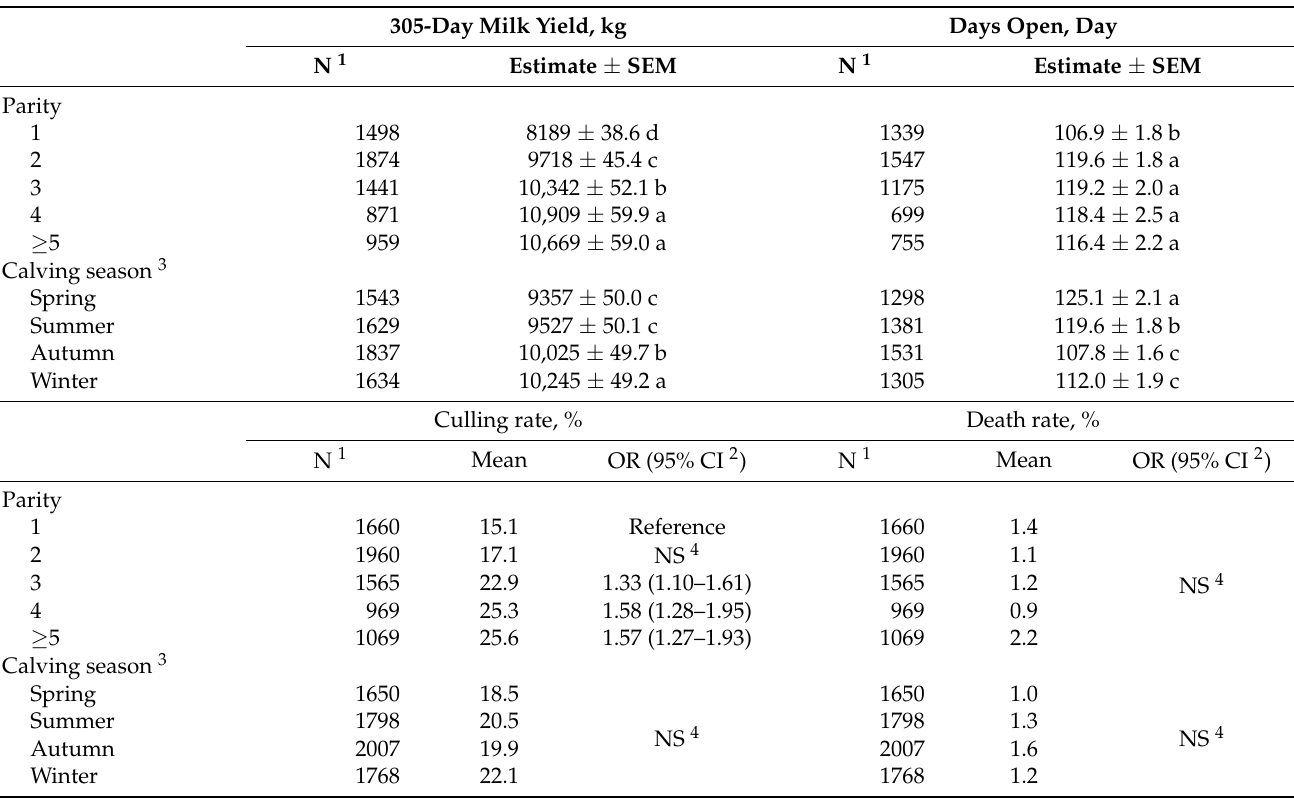
Table 3. Comparison of productivity by parity or calving season (model: clinical mastitis).